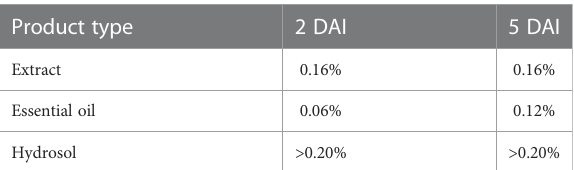
TABLE 2 Minimal inhibitory concentrations (MIC) of products from coriander